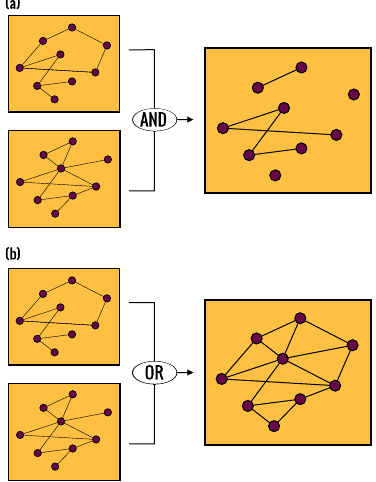
FIG. 1. Network aggregation mechanisms. In aggregated multi- layer networks, different networks containing the same nodes but with different adjacency matrices are combined into an observed network with adjacency matrix A O , where all information about the original layers has been lost. We consider two aggregation mechanisms of two-layer networks with adjacency matrices A 1 and A 2 : (a) AND aggregation, in which A O ij ¼ A 1 ij A 2 ij , so that A O ¼ 1 if, and only if, i and j are connected in both layers,